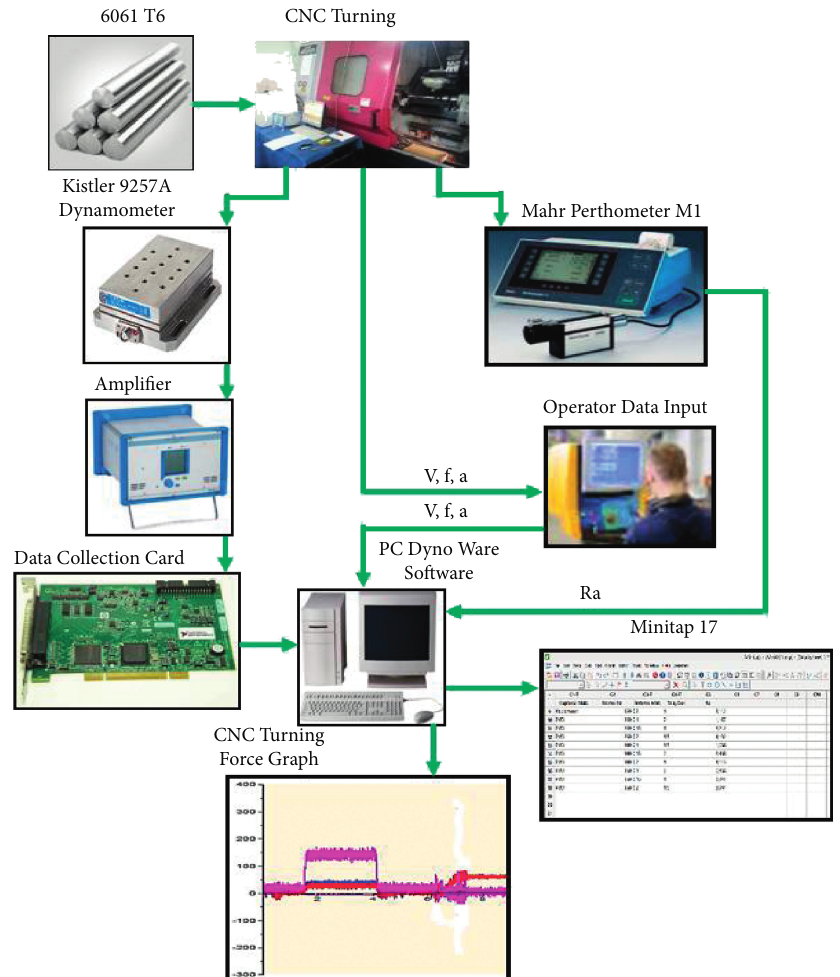
Figure 1: Experimental